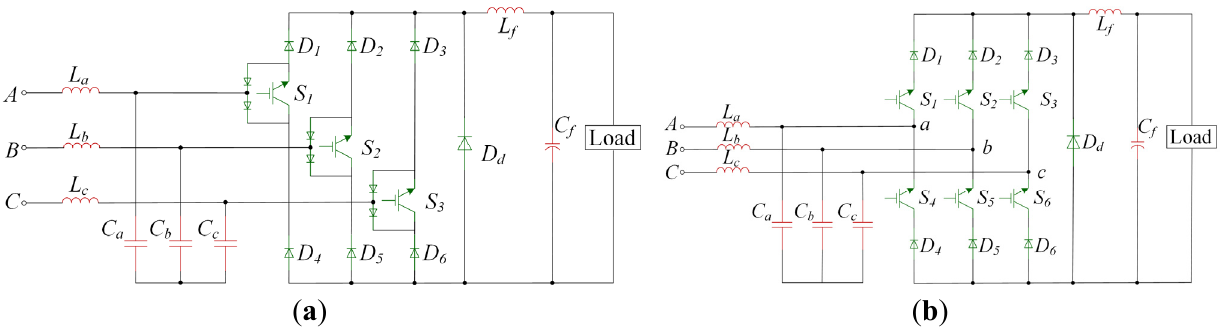
Figure 2. Three-phase AC-DC buck converters: ( a ) three-switch buck converter; ( b ) six switch with free-wheeling diode buck